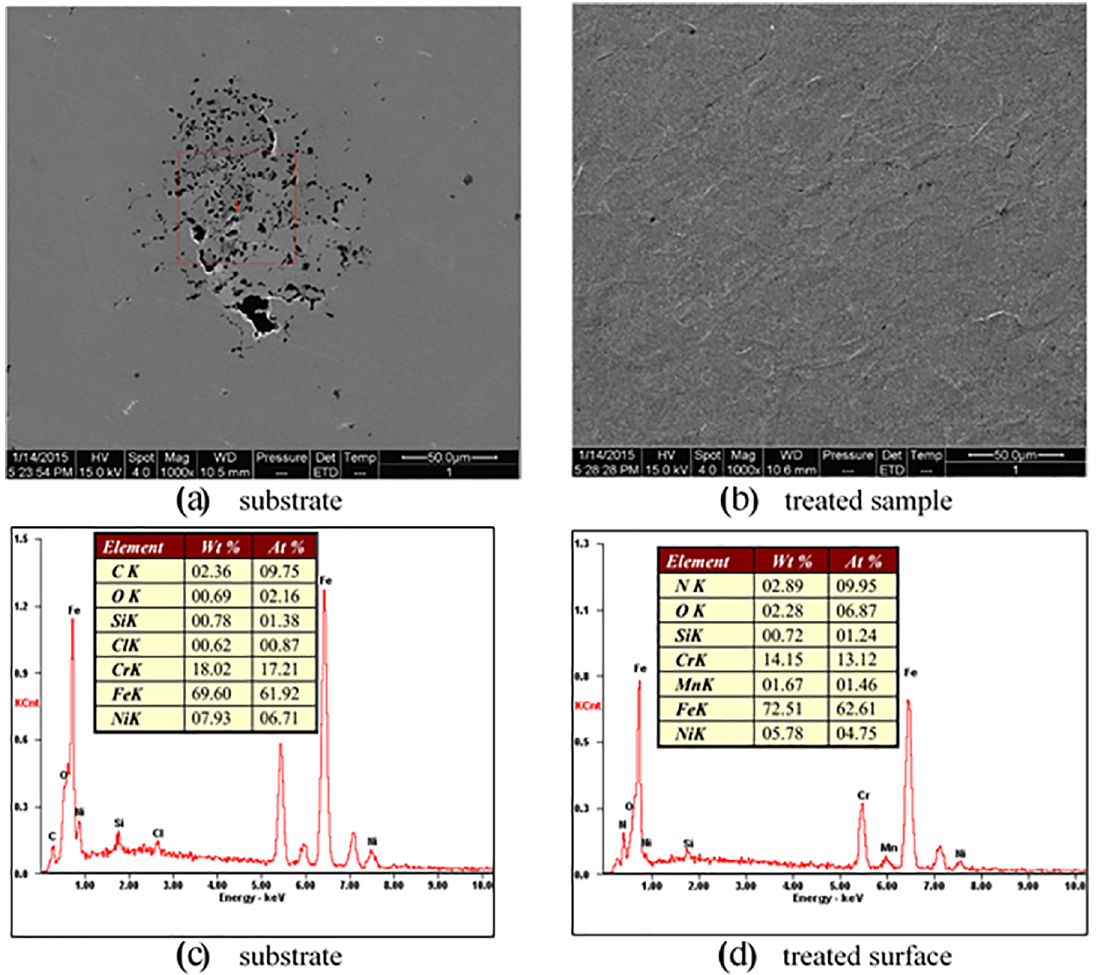
Figure 10 . SEM surface micrographs of the substrate(a) and the 440°C treated sample(b) after polarisation in 3.5% NaCl water solution; EDS microanalysis of the substrate (c) and the treated surface (d) after